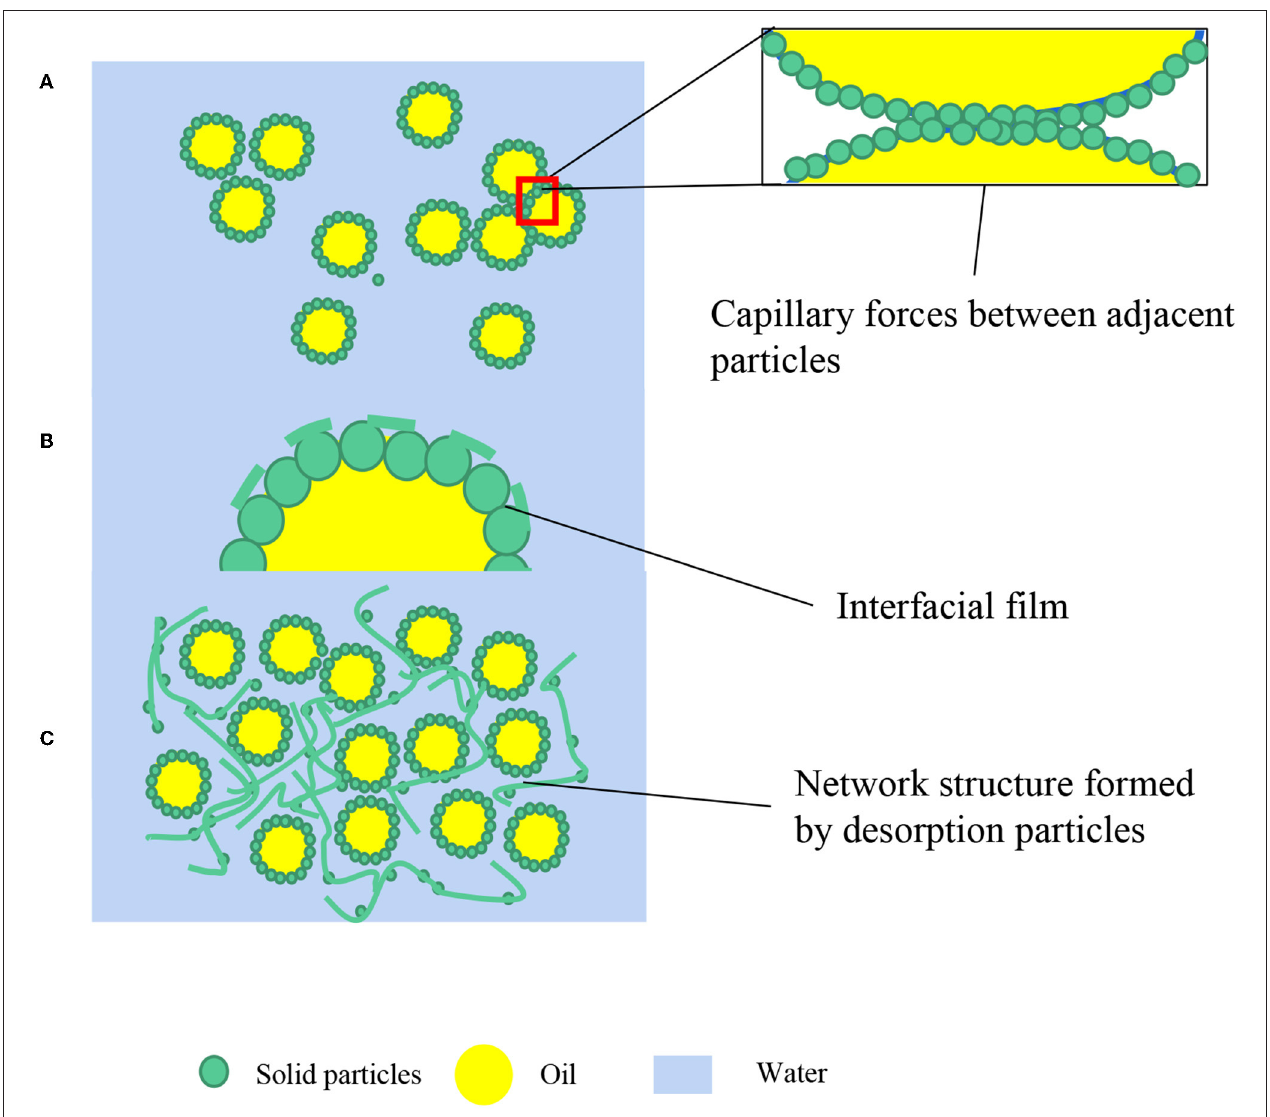
FIGURE 2 | Different stabilization mechanisms of Pickering emulsions. (A) Capillary forces between adjacent particles; (B) Dense interfacial film; (C) Network structure in a continuous